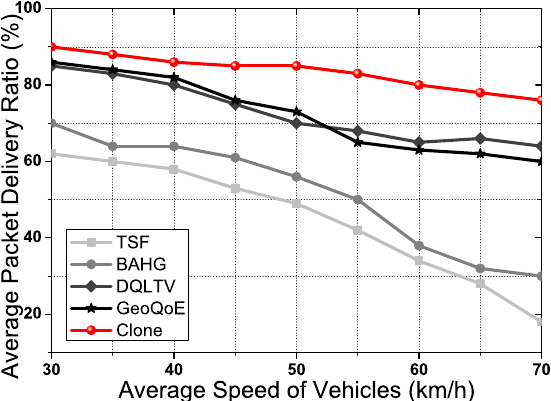
Figure 7. Average packet delivery ratio for average speed of